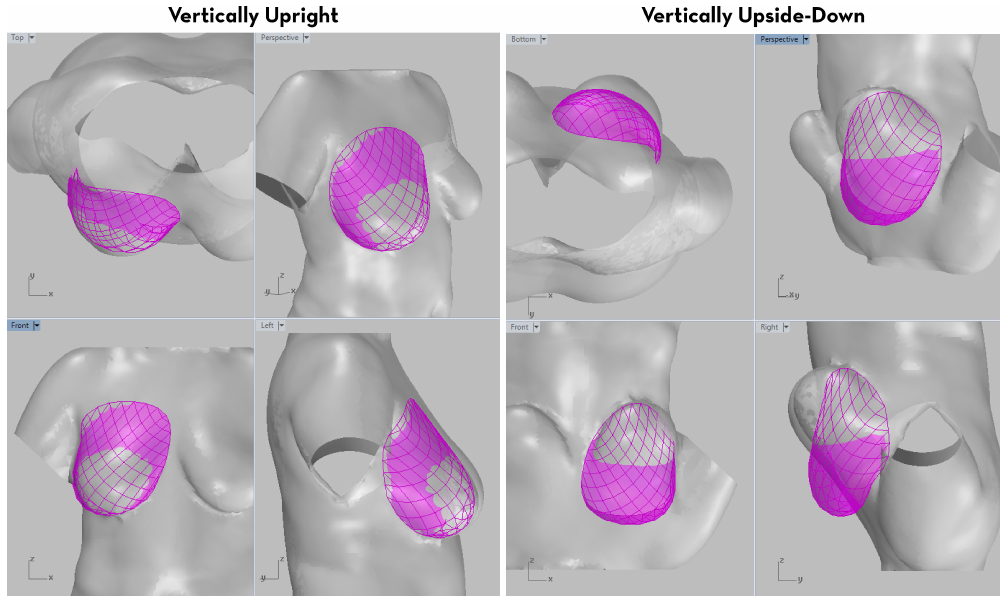
Figure 9. Renderings showing breast simulated at vertical